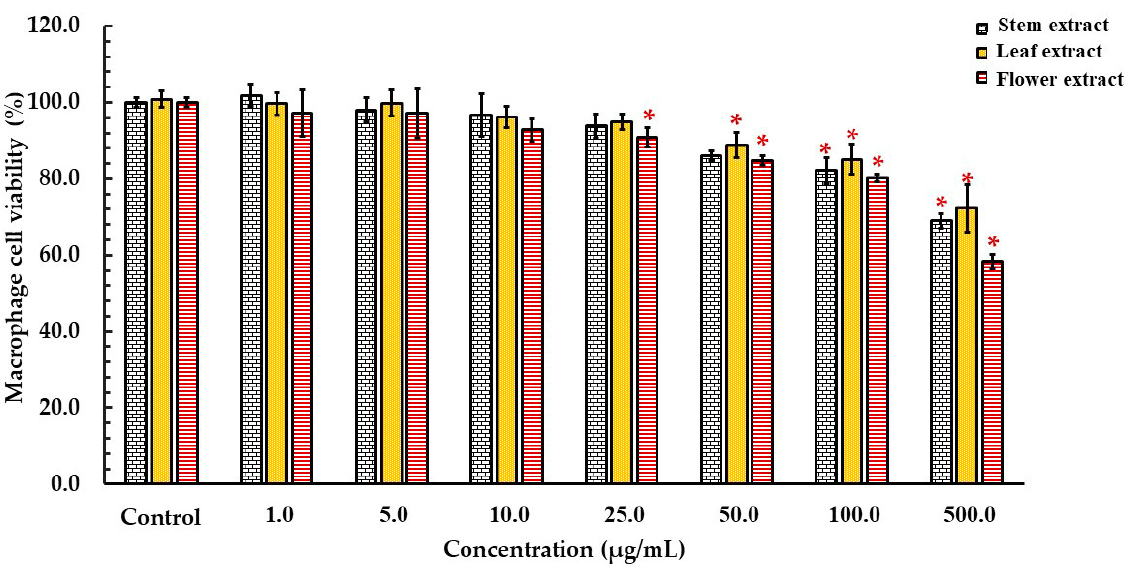
Figure 4. Effect of ethanolic extract of D. sulcatum stems, leaves and flowers on macrophage cell viability using MTT assay. Each value represents the mean ± SD, ( n = 3). * Significantly different versus the control ( p < 0.05, Student’s t -test).